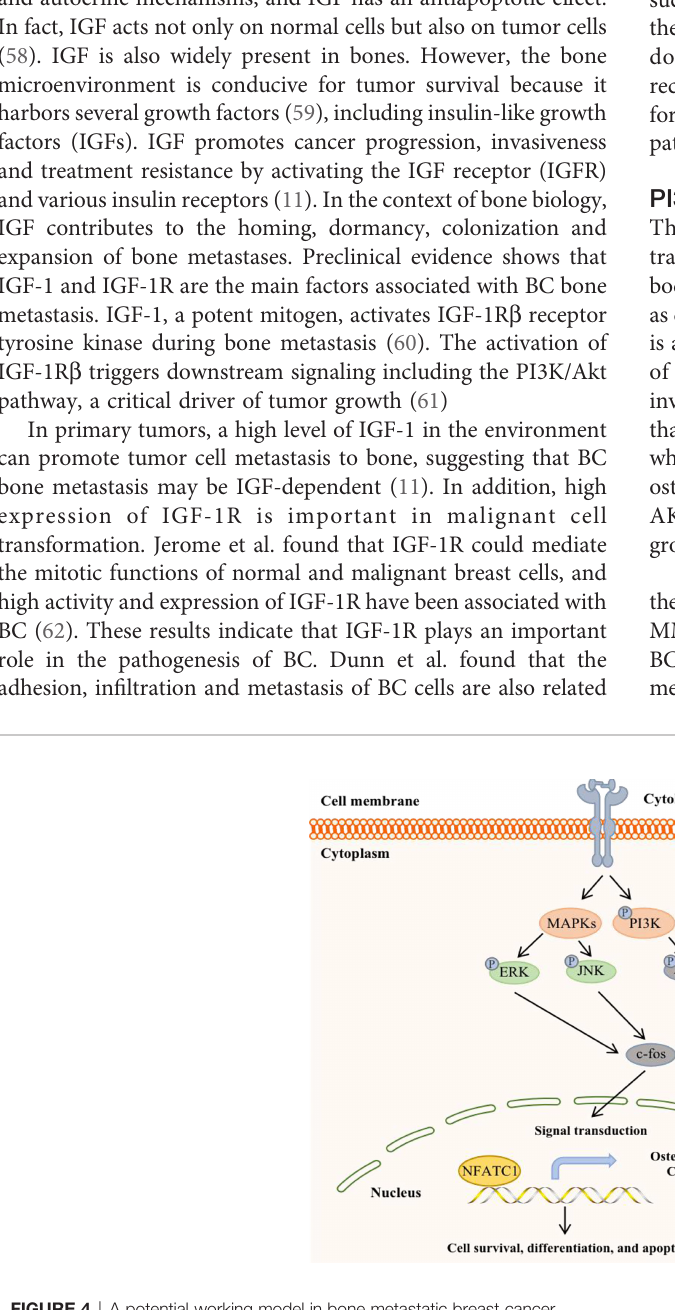
FIGURE 4 | A potential working model in bone metastatic breast